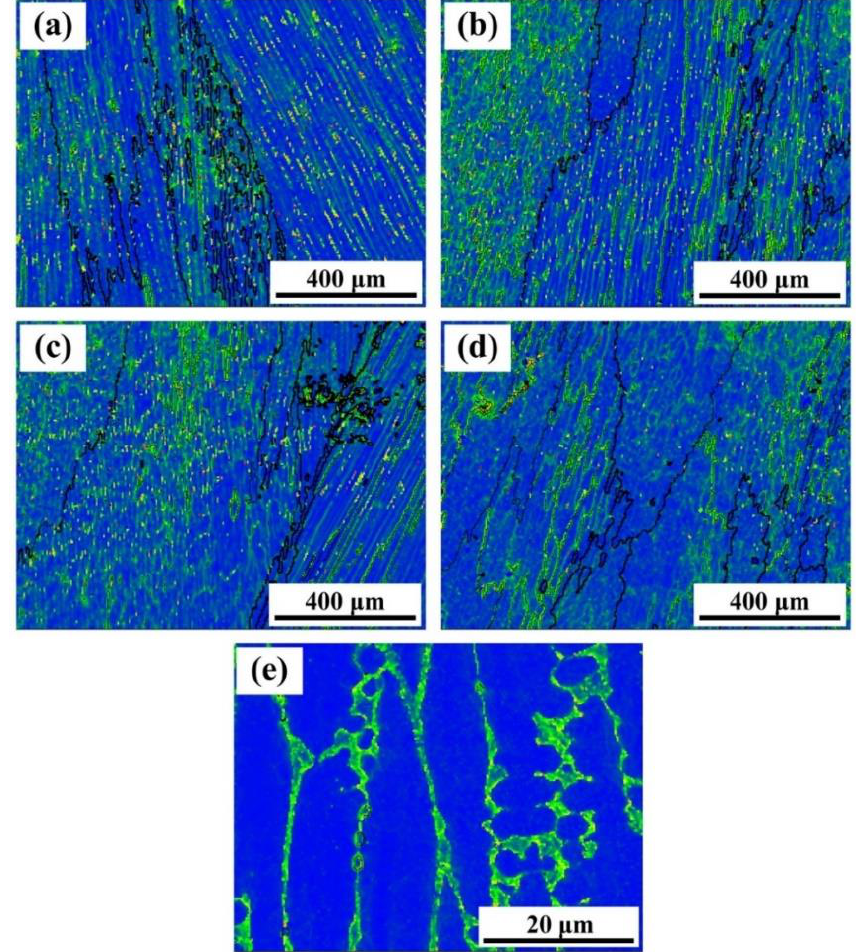
Figure 14. The KAM maps of the LMD-Al 0.5 FeCoCrNi HEA under different heat dissipation rates: ( a ) T-0; ( b ) T-20; ( c ) T-40; ( d ) T-60; ( e ) The enlarged map.